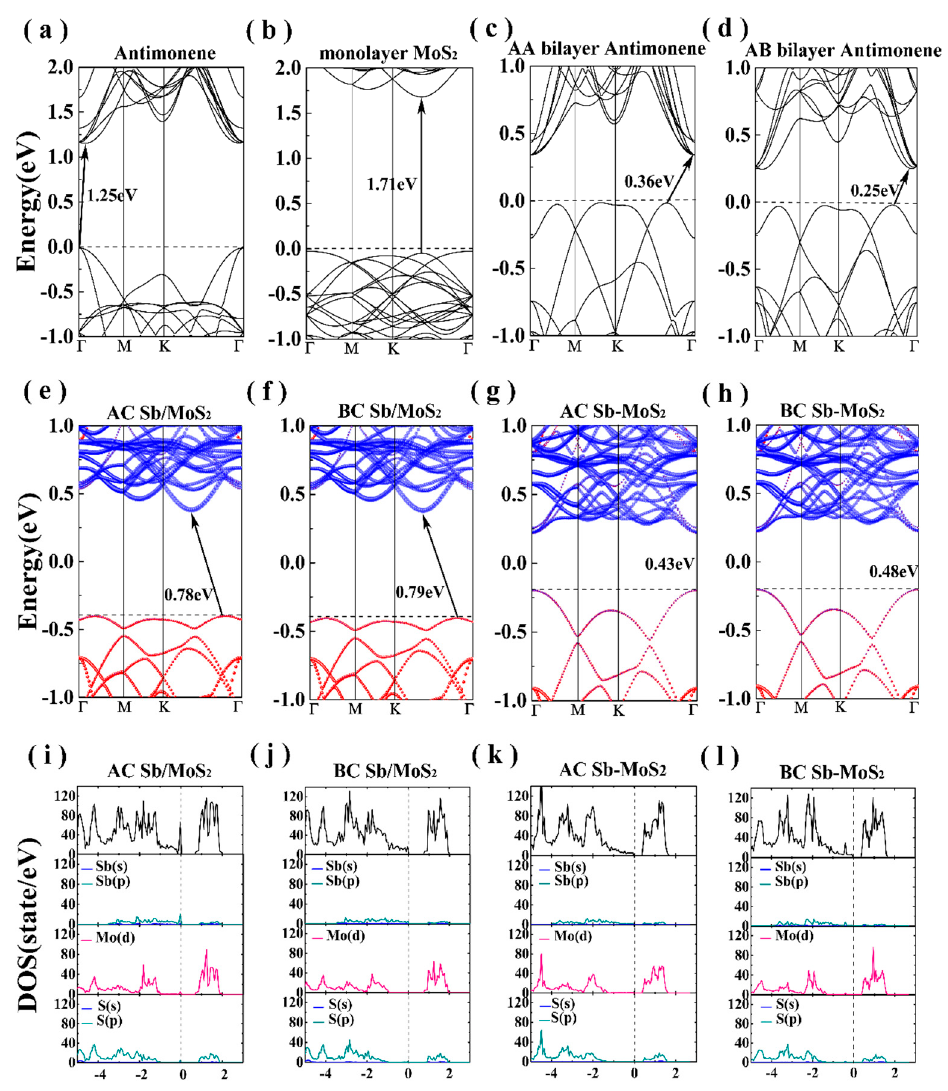
Figure 2. Band structures of ( a ) antimonene, ( b ) MoS 2 monolayer, ( c ) AA bilayer antimonene, ( d ) AB bilayer antimonene, ( e ) AC Sb/MoS 2 hetero-bilayer, ( f ) BC Sb/MoS 2 hetero-bilayer, ( g ) AC Sb/MoS 2 superlattice and ( h ) BC Sb/MoS 2 superlattice. The density of states of ( i ) AC Sb/MoS 2 hetero-bilayer, ( j ) BC Sb/MoS 2 hetero-bilayer, ( k ) AC Sb/MoS 2 superlattice and ( l ) BC Sb/MoS 2 superlattice. The black dotted line indicates the Fermi level.